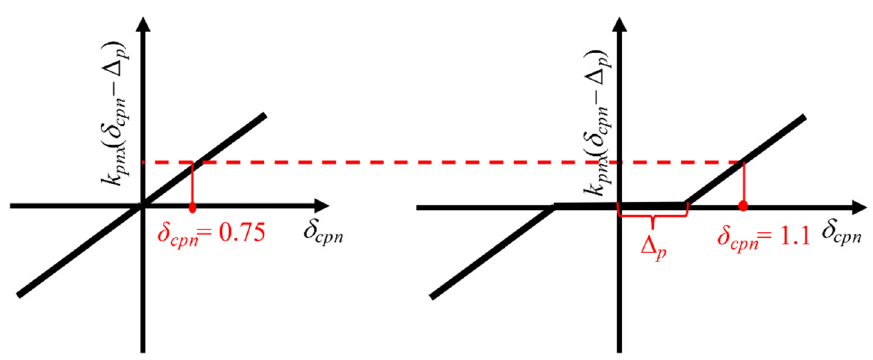
Figure 15. The schematic diagram for the k pnx ( δ cpn – Δ p ).